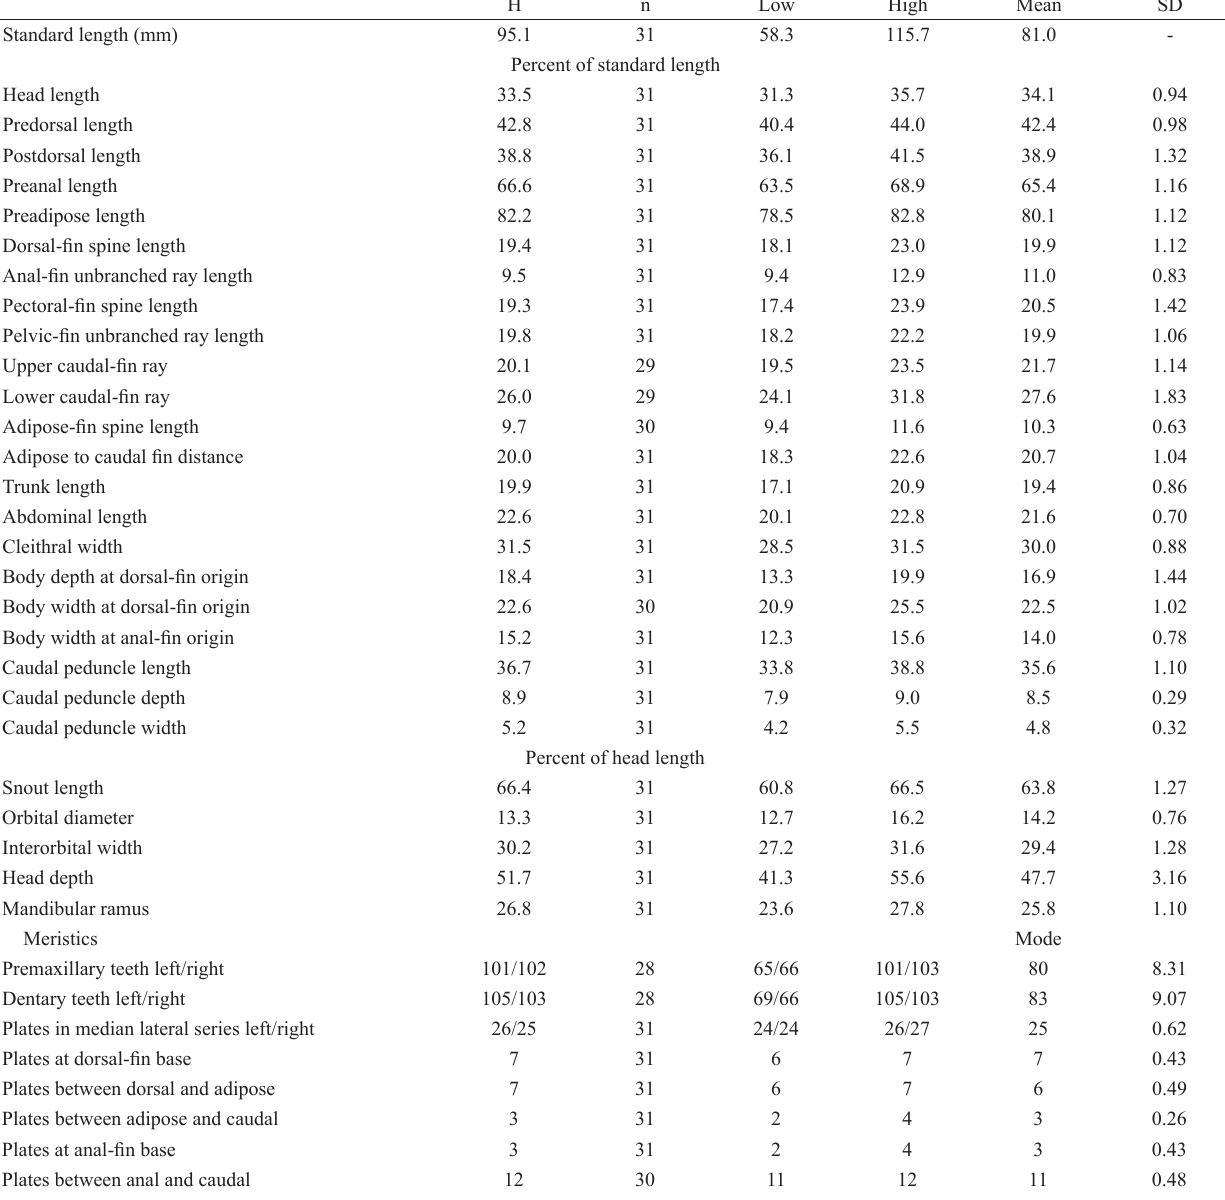
Tab. 1 . Morphometric and meristic data of Pareiorhaphis lineata . Values are given as percents of standard length or head length. H = holotype, n = number of specimens, and SD = standard